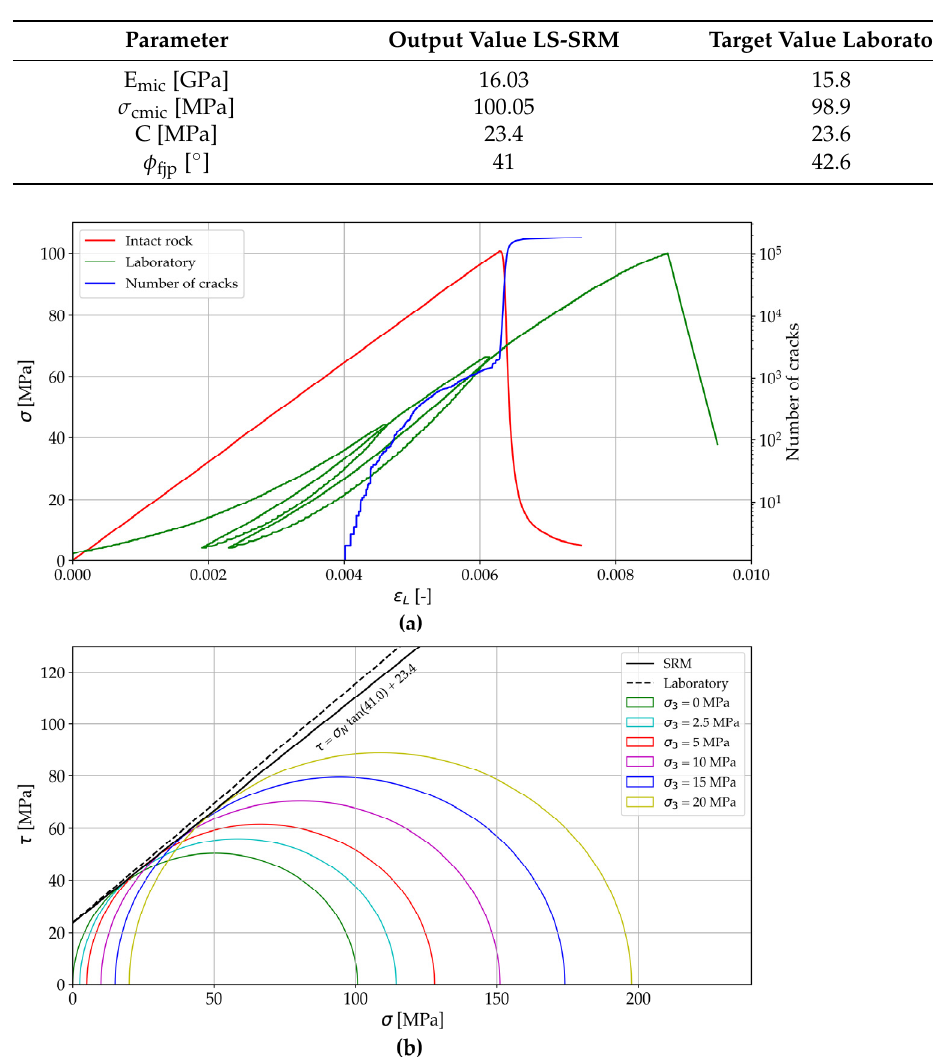
Figure 6. Results of the intact rock models on laboratory scale. ( a ) Stress–strain curve for the intact rock measured in the laboratory and the SRM model, including the evolution in the number of cracks; ( b ) Results of triaxial experiments at various confining pressures.